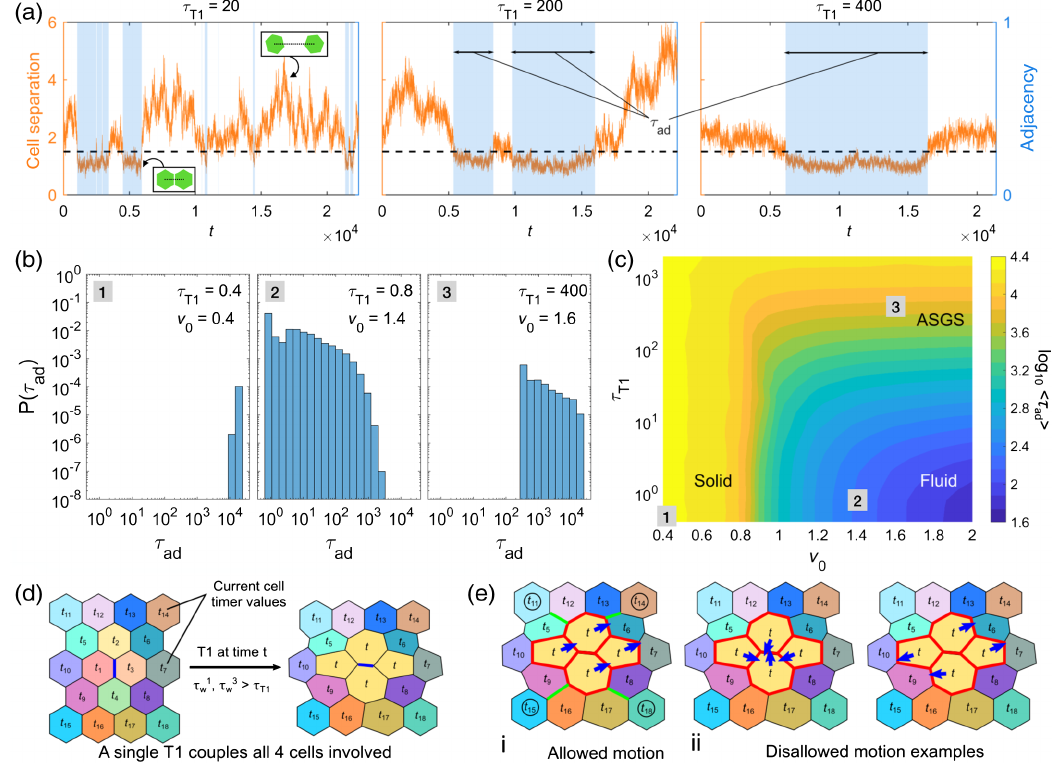
FIG. 6. Effective cell-cell cohesion depends on T1 stalling timescale and introduces cell streaming. (a) Typical time evolution of the adjacency (blue) and center-to-center distance (orange) of a pair of cells. Adjacency is 1 when the pair are immediate neighbors (i.e., sharing a junction) and zero when they are not neighbors. Width of the blue shaded areas indicates periods for which they form a cohesive pair, defined as the effective adhesion timescale τ . The time evolution of cell-cell separation provides another measure of τ , ad ad given by the periods for which the separation remains below a suitably chosen fixed threshold of 1.5 times an average cell diameter. Examples are shown for different τ at fixed v 0 ¼ 1 . 6 which show that cell pairs can undergo multiple events of cohesion, and the two T 1 different methods of determining τ agree quite well. See Fig. 11(d) in Appendix B for more data on comparison of these two methods. ad (b) Probability distribution functions of the effective adhesion timescales P ð τ , shown at different combinations of v 0 and τ . (c) A ad Þ T 1 color map of h τ , estimated from cell adjacency information as a function of τ and v 0 . (d),(e) Proposed mechanism of how effective ad i T 1 cohesion can lead to cell streaming. (d) shows a tissue patch of 18 cells, each with a different timer δ t i ¼ t i recording the time elapsed since the last T1. Cells 1 and 3 (sharing the blue colored junction) undergo T1 at time t as their respective waiting times exceed τ . This T 1 T1 not only resets the timers on cells 1 and 3, it also resets the timers on nearby cells 2 and 4, because they now become neighbors after the T1. This resetting introduces an effective adhesion in several cell pairs and forbids another T1 event involving the junctions colored in red for a period at least τ . (e) shows the consequence of this effect. These four cells can now only move coherently [case (i)] with T 1 types of motions forbidden, as illustrated here [case (ii)]. Thus, this cluster of four cells acts as a nucleator for a cell stream, that can grow in length as any of the neighboring cells, marked by circles [case (i)], can join the cluster via T1 transitions involving the junctions colored green [case (i)] and propagate the